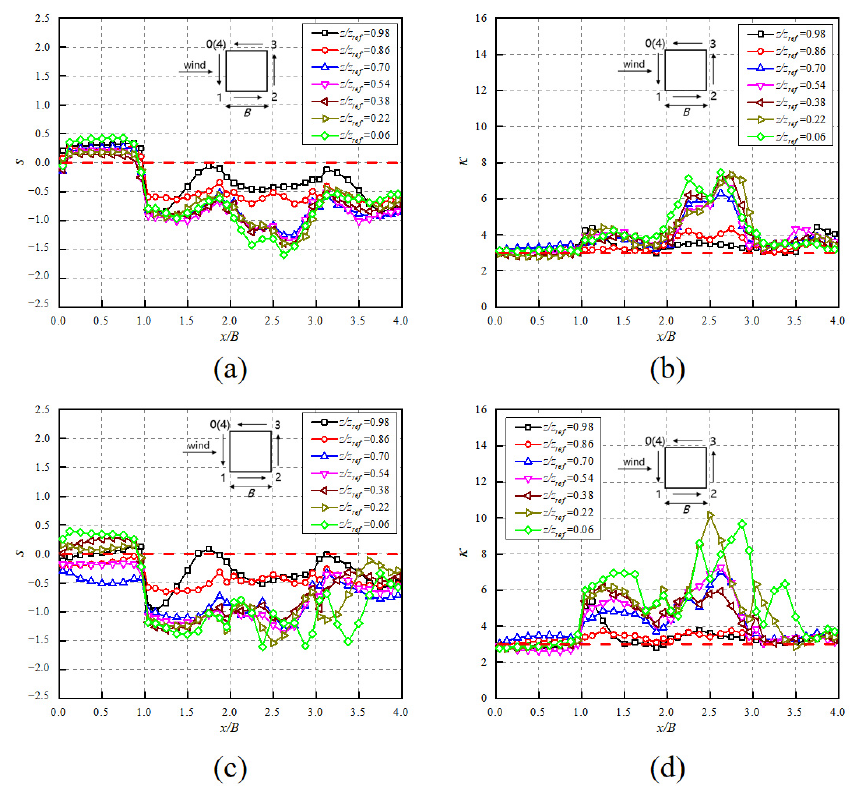
Figure 10. Skewness and Kurtosis of the pressure records at different layers: ( a , b ) CWF2-0°; and ( c , d ) TWF20-0°.